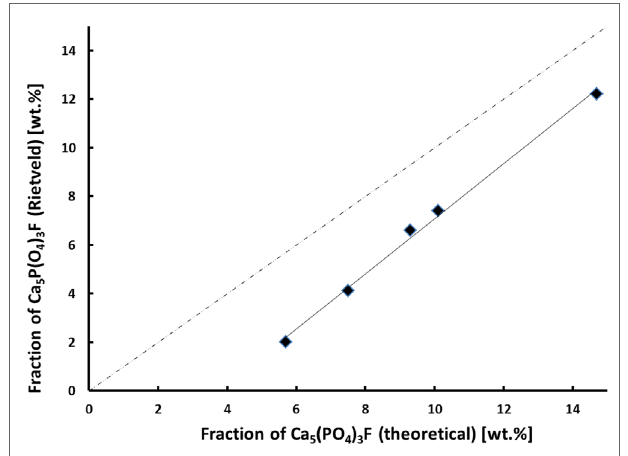
FigUre 7 | experimentally estimated fraction of ca 5 (PO 4 ) 3 F as a function of the theoretically feasible fraction based on the chemical glass composition .